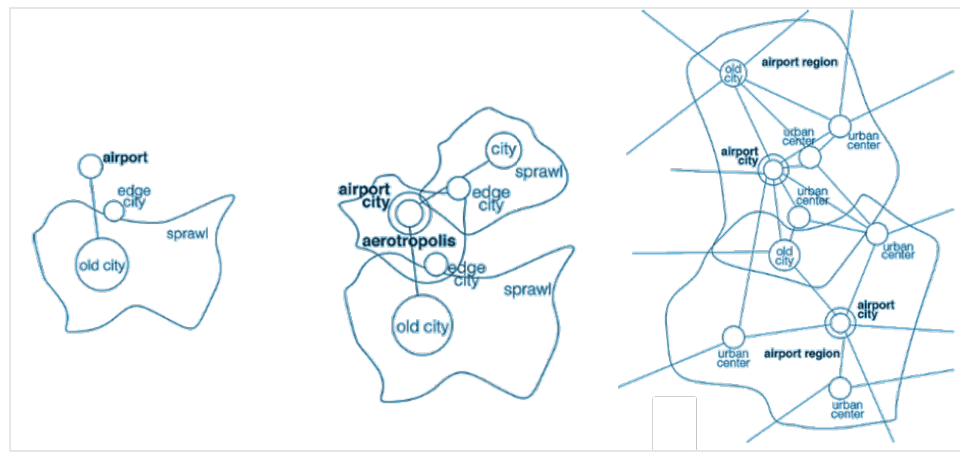
Figure 1. Advent of the airport region